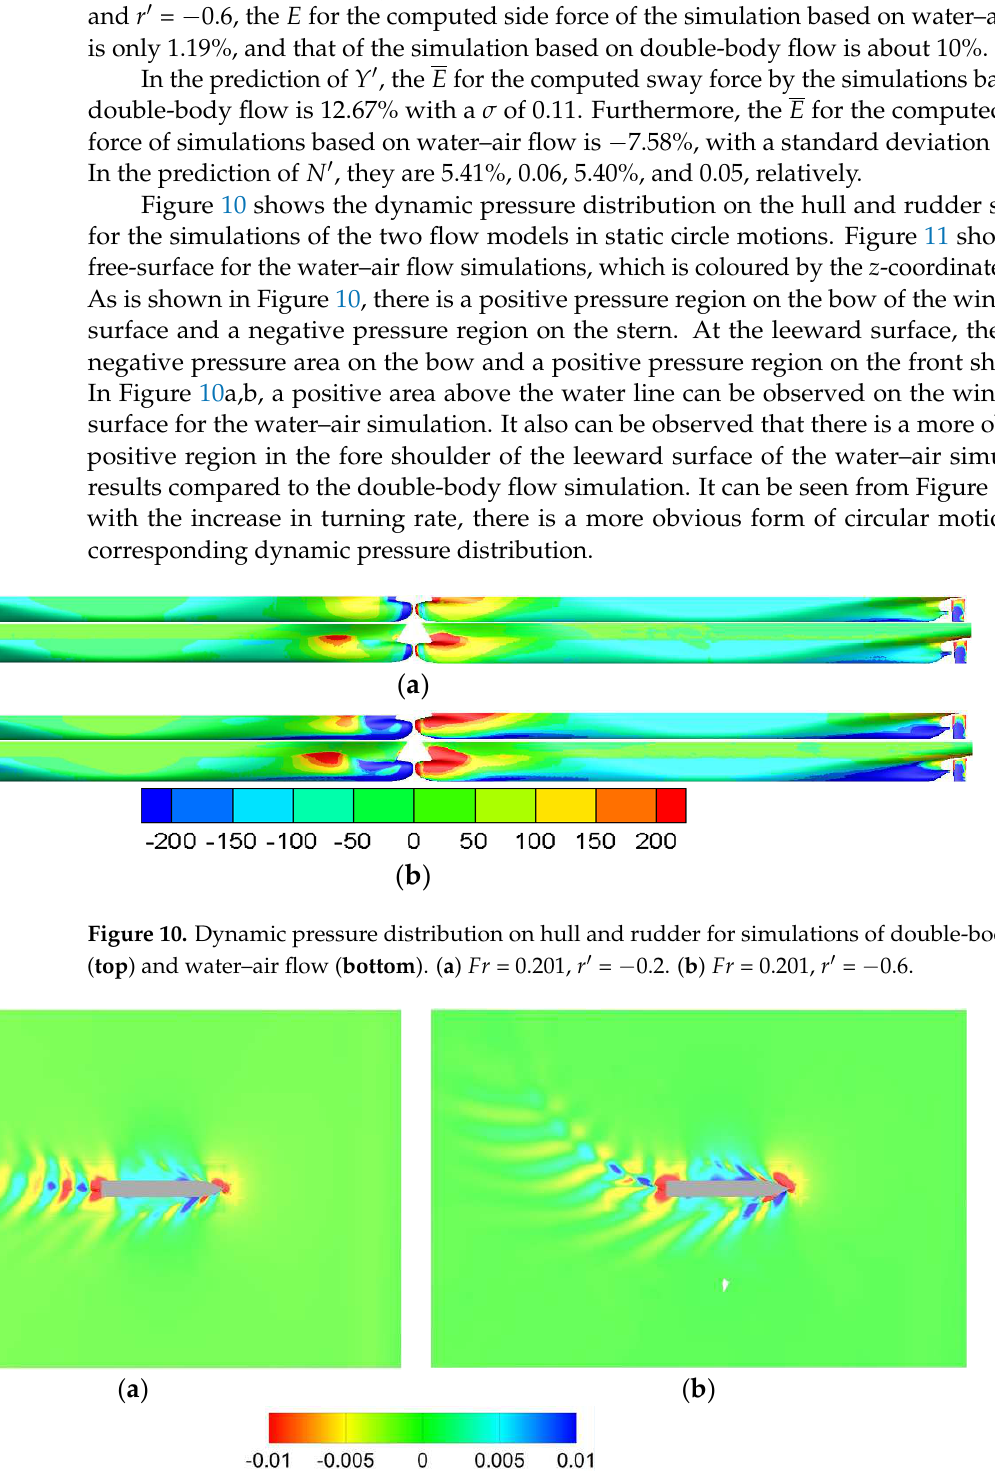
Figure 11. Free-surface for static turning simulations of water–air flow. ( a ) Fr = 0.201, r (cid:48) = − 0.2. ( b ) Fr = 0.201, r (cid:48) = − 0.6.